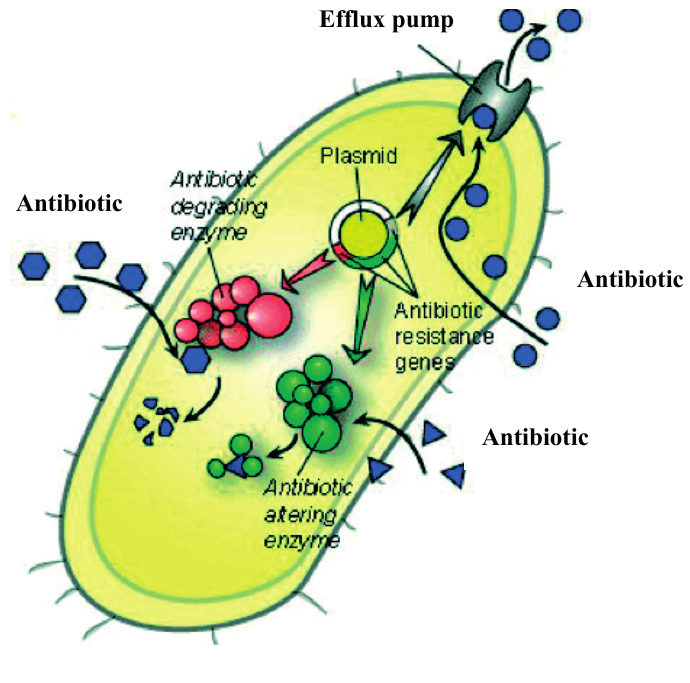
Figure 1. The main mechanisms of AMR: overproduction of efflux pumps, antibiotic modification and antibiotic degradation (reproduced from [2] with